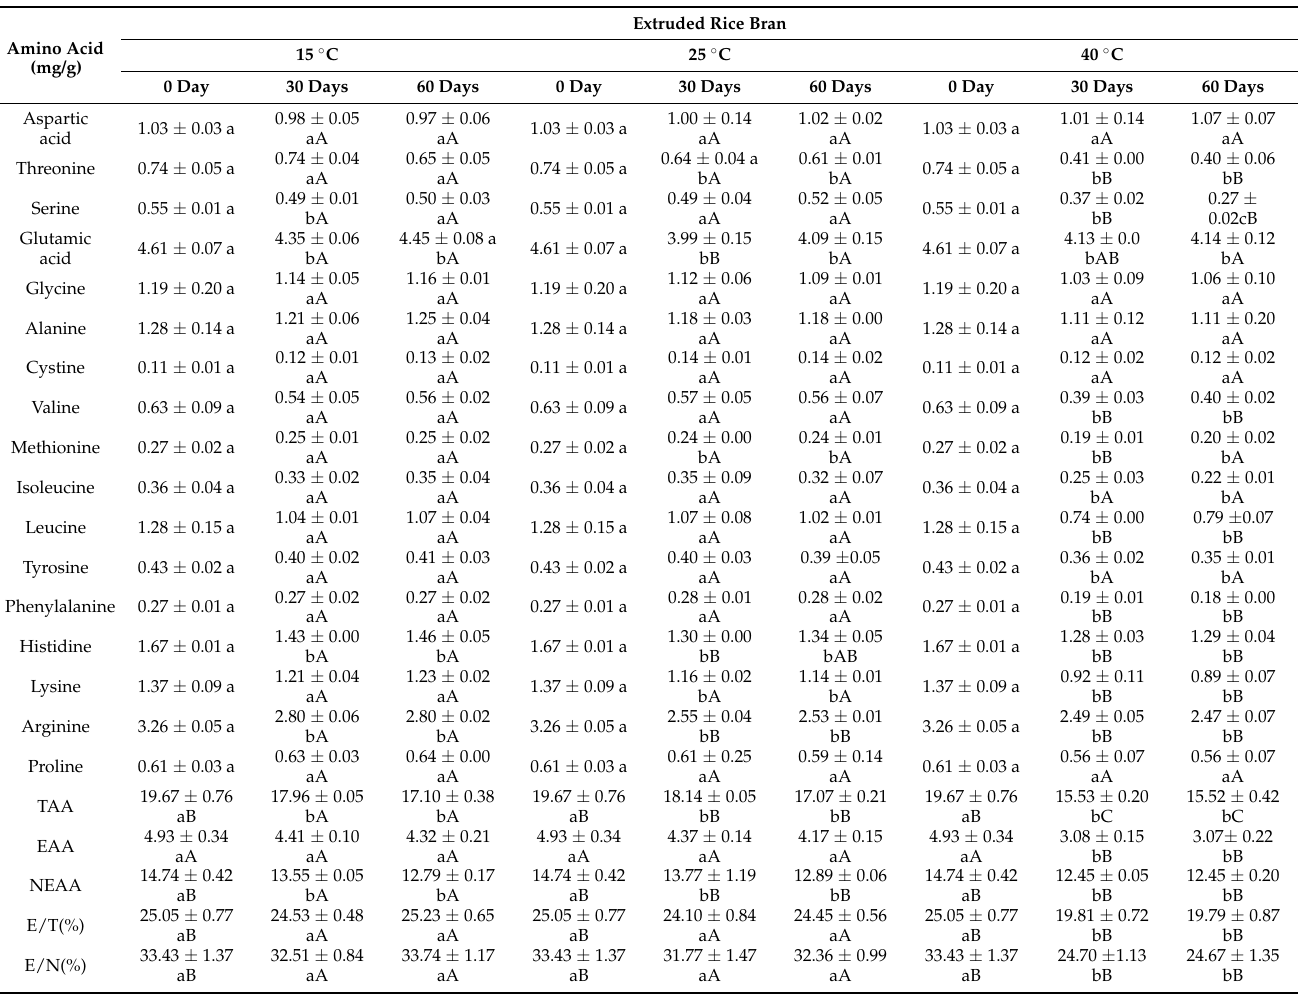
Table 6. Changes in amino acid composition and content in extruded rice bran during